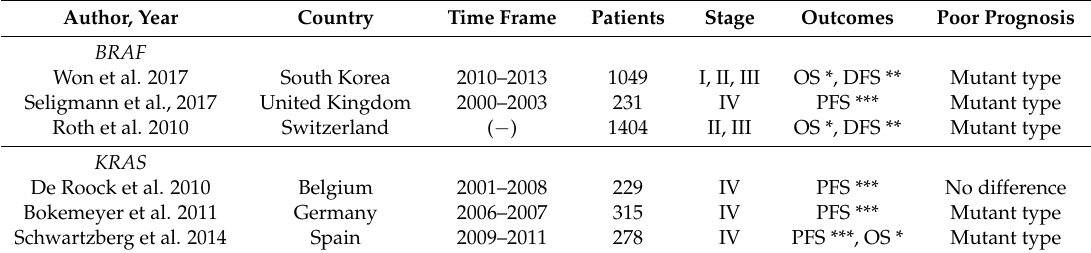
Table 2. BRAF / KRAS status and prognosis in previous